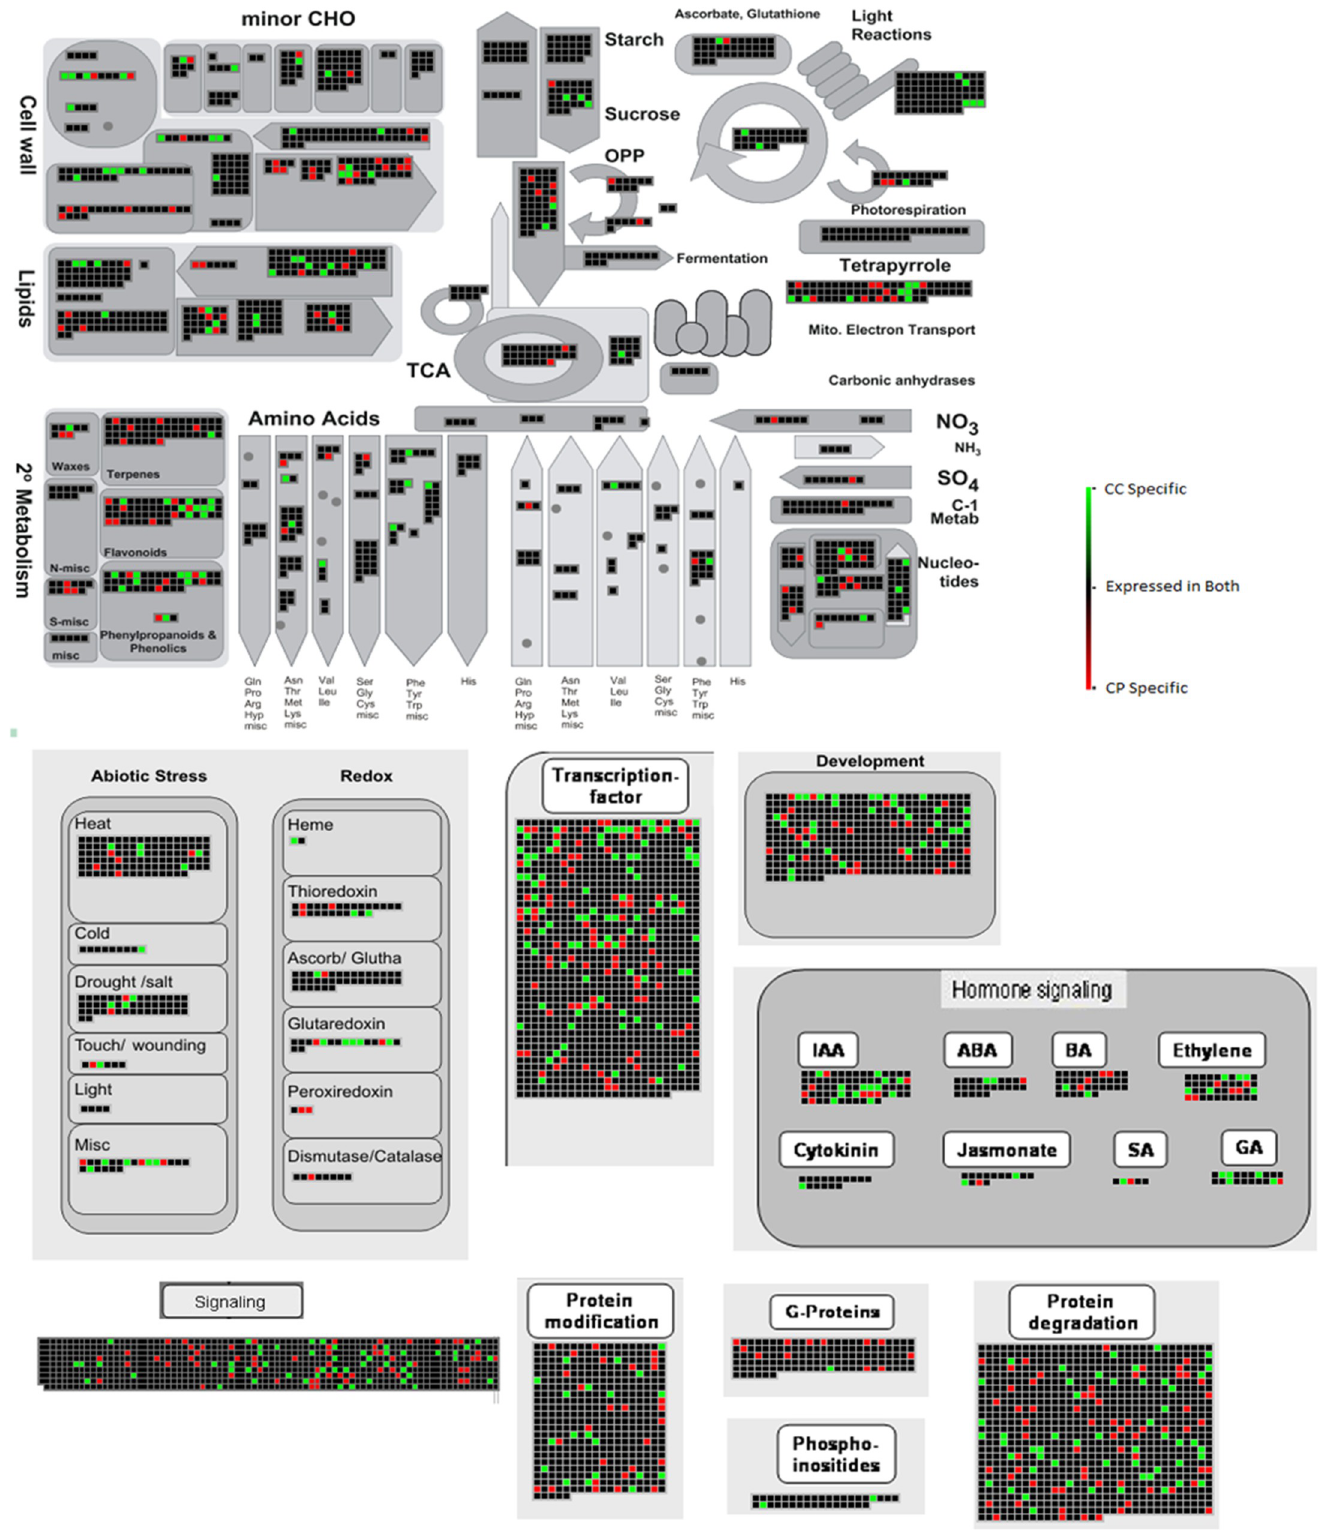
Fig 6. MapMan analysis depicting gene expression in functional categories associated with different pathways in both the Cajanus species.